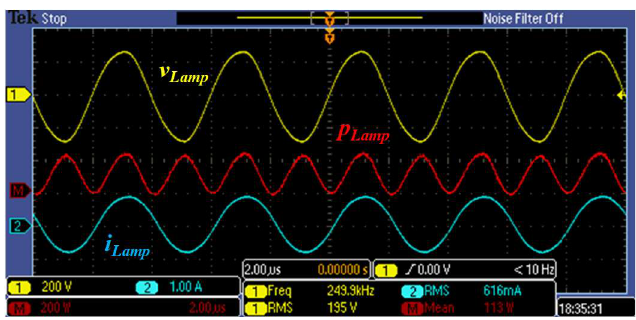
Figure 15. EFL lamp voltage ( v lamp ), current ( i lamp ) and power ( p lamp ) operating in steady state.